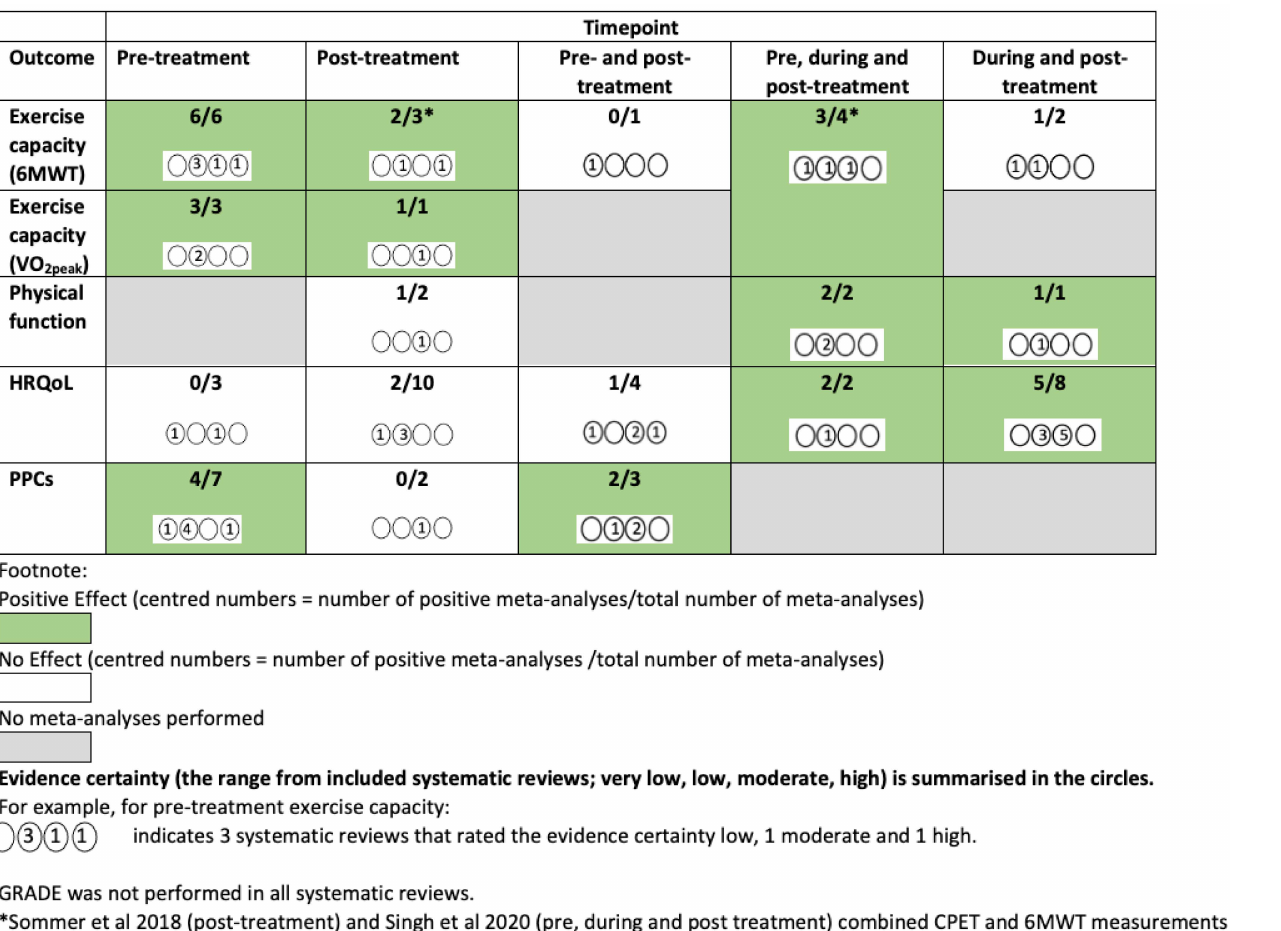
Figure 2. GRADE evidence map (excluding subgroup analyses and longer-term follow-up)